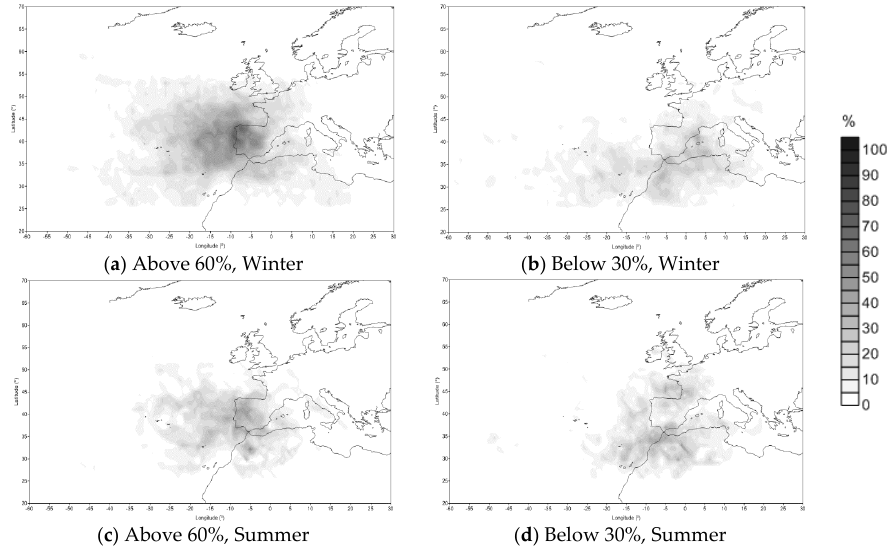
Figure 4. Composite analysis for Methodology 2 for all events with a production ( a ) higher than 60% over the installed capacity for Winter ( b ) lower than 30% over the installed capacity for Winter ( c ) higher than 60% over the installed capacity for Summer ( d ) lower than 30% over the installed capacity for Summer. The TC values are 151 and 91 for Winter and Summer months, respectively.